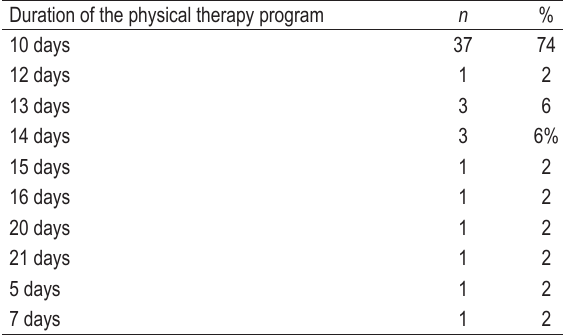
TABLE 4. Display of the duration of the physical therapy program